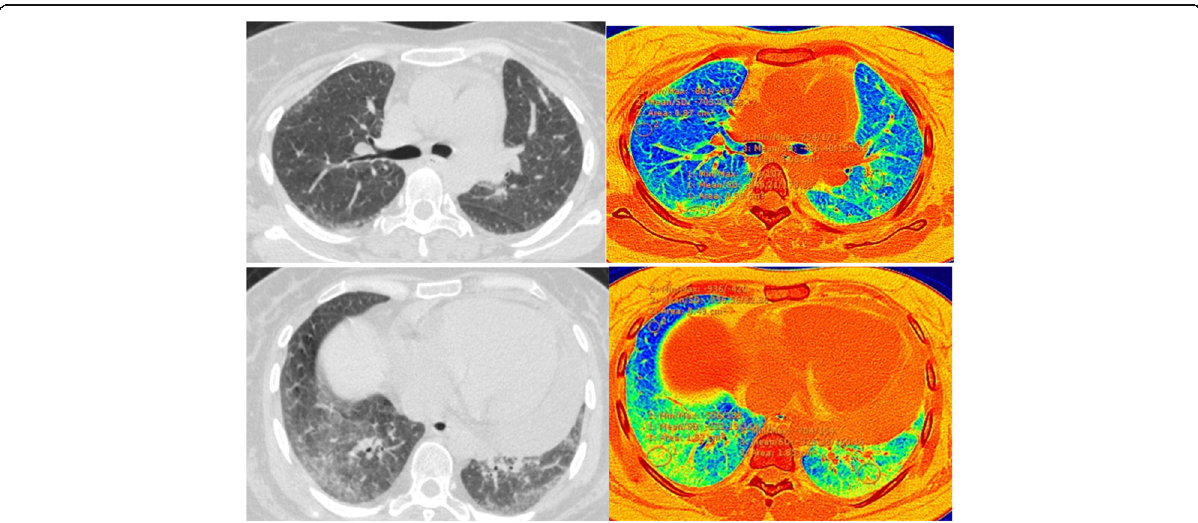
Fig. 5 A 40-year-old female patient, diagnosed as NSIP (reported case of scleroderma). HRCT axial lung and color-coded density images showing bilateral fairly symmetrical subpleural ground glass opacification and reticulation with minimal traction bronchiolectatic change with dilated pulmonary artery and pericardial effusion. Color-coded images allowed better evaluation of area reticulation and honeycombing (yellow color) for HU above − 750 and blue color for normal lung ranging between − 750 and − 900 HU